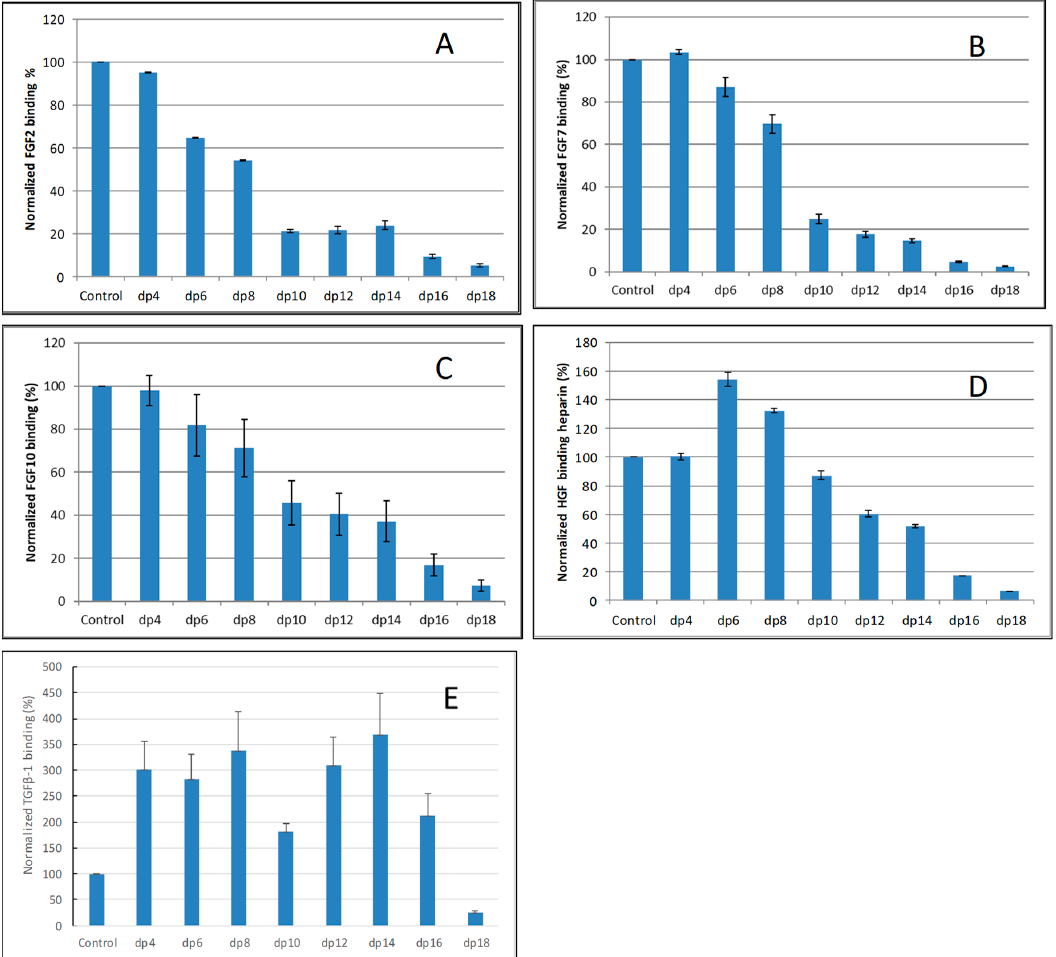
Figure 3. Bar graphs of normalized di ff erent growth factors binding preference to surface heparin by competing with di ff erent size of heparin oligosaccharides (from fp4 to dp18). ( A ) FGF2, ( B ) FGF7, ( C ) FGF10, ( D ) HGF, ( E ) TGF β -1. Concentrations were 200, 100, 100, 20, and 50 nM for FGF2, FGF7, FGF10, HGF and TGF β -1, respectively, and concentrations of heparin oligosaccharides were 1000 nM. All bar graphs based on triplicate experiments.